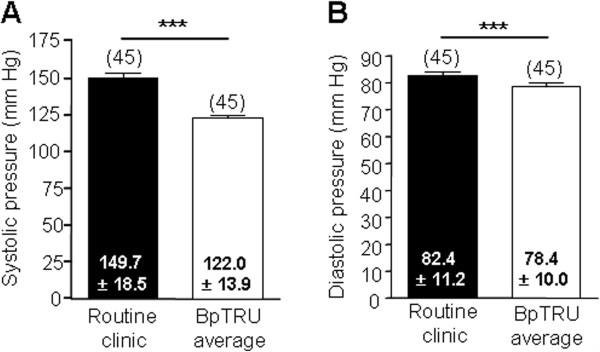
Comparison between routine clinic BP and BpTRU measurements. A. Bar graph showing comparison between routine clinic systolic BP and mean systolic BP measured with BpTRU. Routine clinic systolic was significantly higher than BpTRU systolic (P < 0.0001; paired t-test; 'n’ in parentheses). B. Bar graph showing comparison between routine clinic diastolic BP and mean diastolic BP measured with BpTRU. Routine clinic diastolic was significantly higher than BpTRU diastolic (P = 0.0033; paired t-test; 'n’ in parentheses).